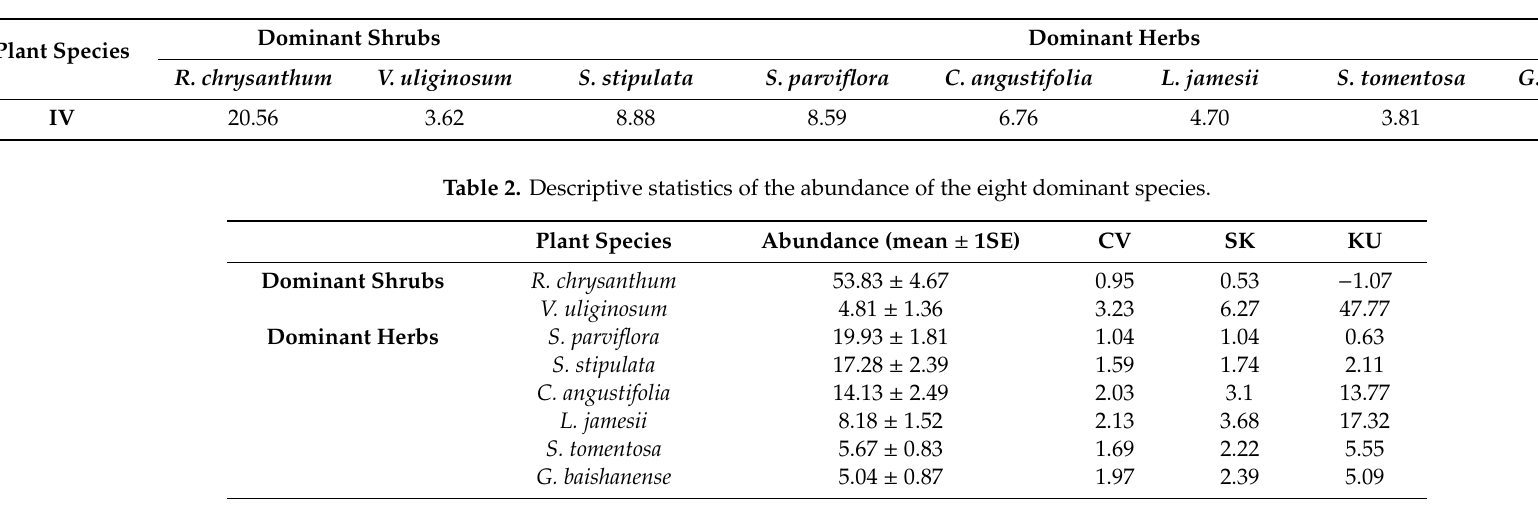
Table 3. The p values showing the e ff ects of environmental factors on abundance of the eight dominant plant species, tested with one-way ANOVAs. R. df